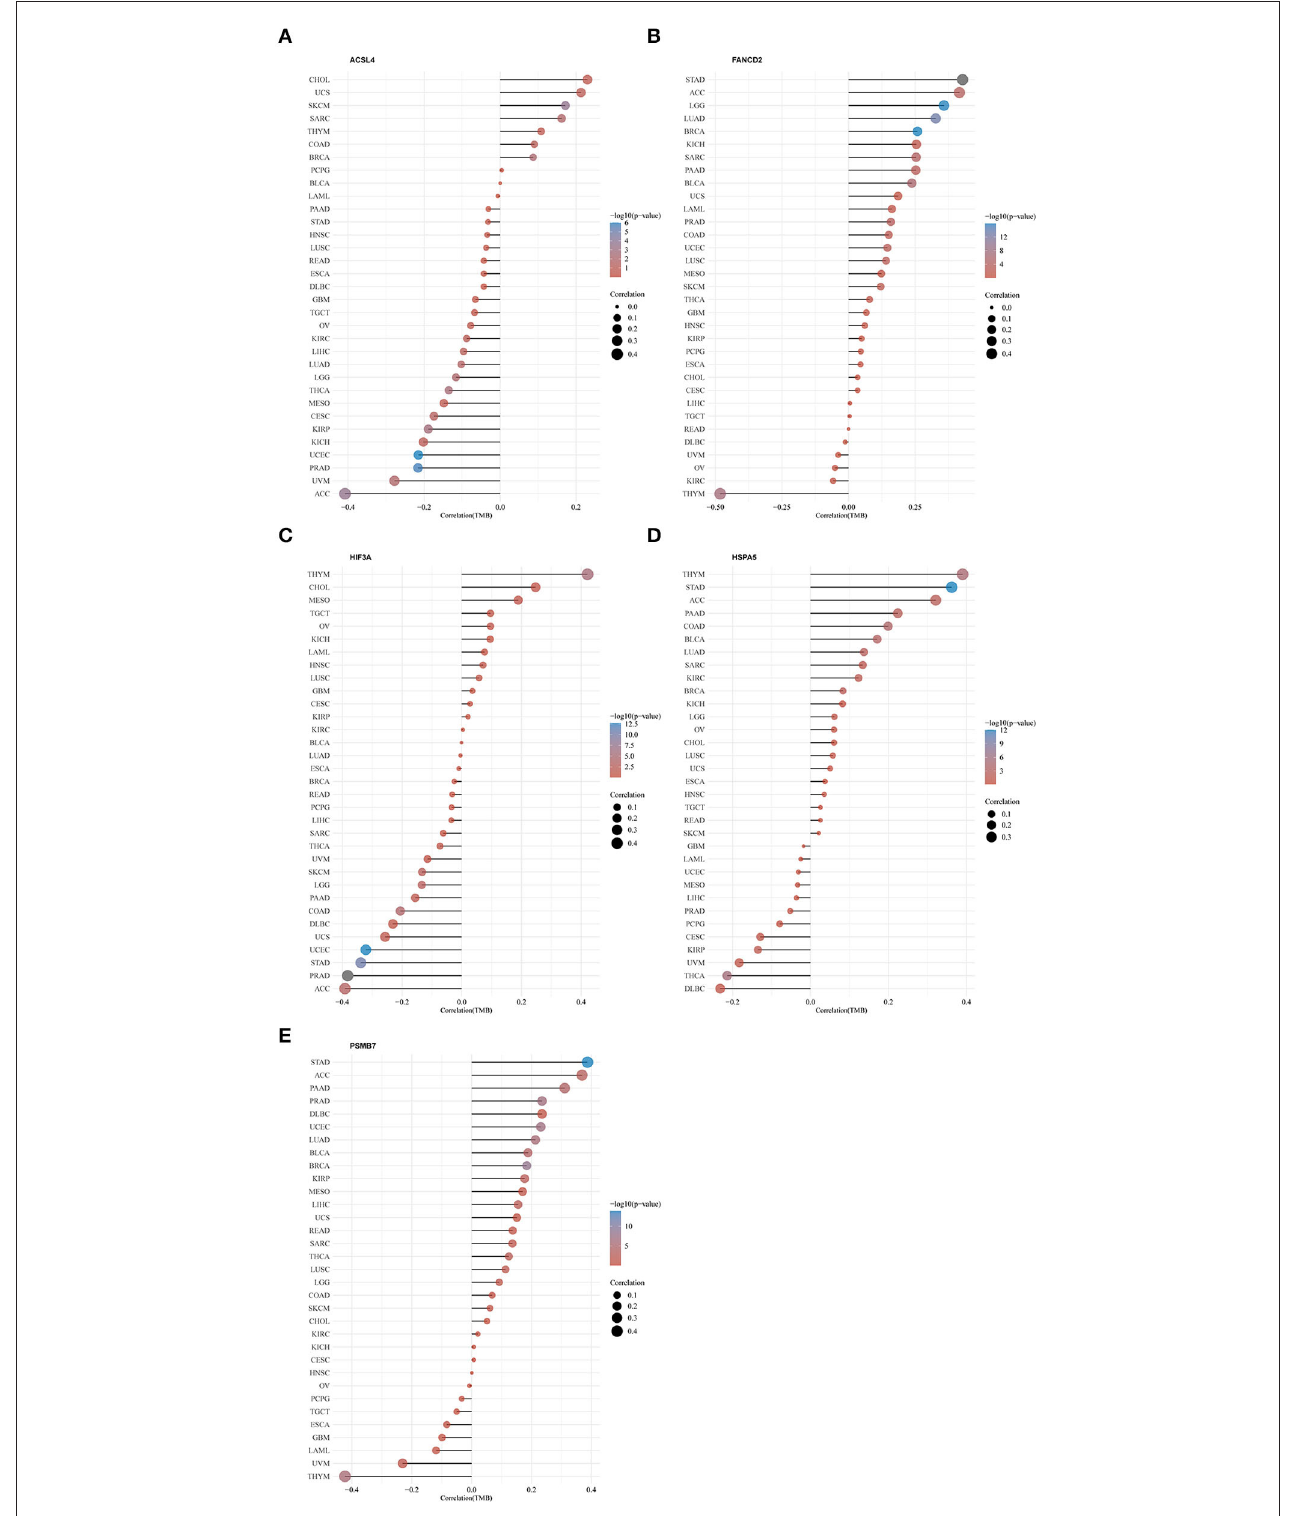
FIGURE 9 | Pan-cancer analysis of five hub genes in the predictive model and TMB. (A) ACSL4; (B) FANCD2; (C) HIF3A; (D) HSPA5; (E) PSMB7. TMB: tumor mutation burden. The full names of the 33 cancers are available on the Cancer Genome Atlas (TCGA) database (https://portal.gdc.cancer.gov/repository).